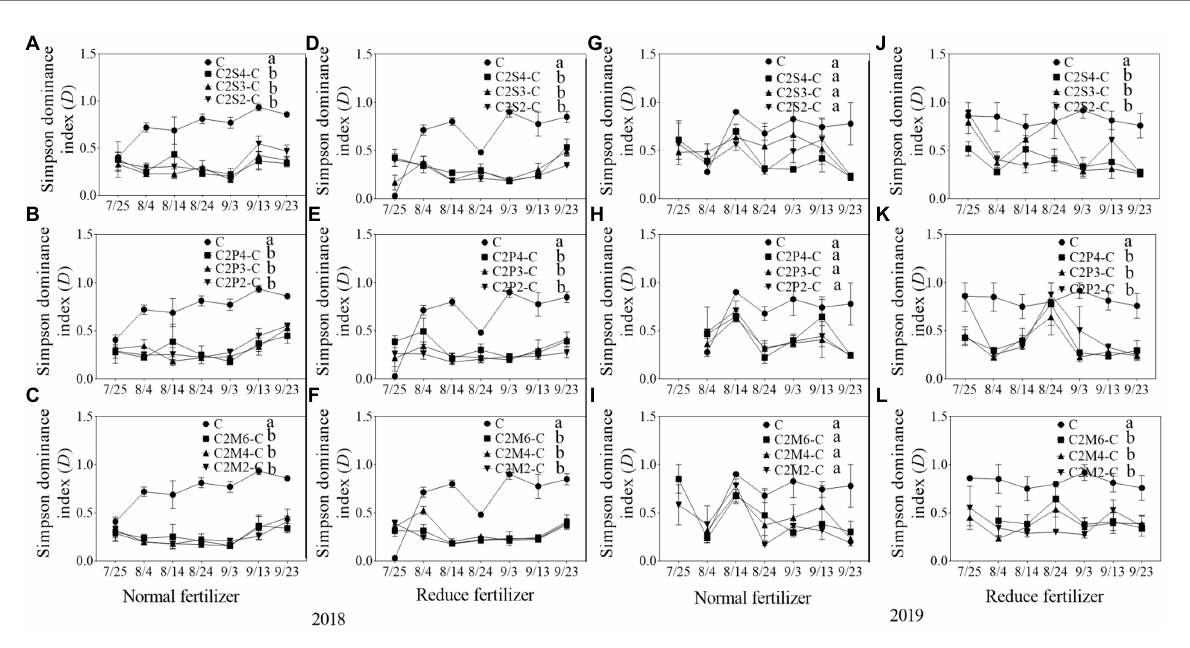
FIGURE 4 Simpson dominance index (D) of insect communities on corn plants intercropping with soybean, peanut, and millet under different planting patterns at normal and reduced fertilizer. A-C represent corn-soybean intercropping, corn-peanut intercropping and corn-millet intercropping under normal fertilizer in 2018, respectively. D-F represent corn- soybean intercropping, corn-peanut intercropping and corn-millet intercropping under fertilizer reduction in 2018, respectively. G-I represents corn-soybean intercropping, corn-peanut intercropping and corn-millet intercropping under normal fertilizer in 2019, respectively. J-L represent corn-soybean intercropping, corn- peanut intercropping and corn-millet intercropping under fertilizer reduction in 2019, respectively. C2S2-C, C2S3-C, C2S4-C: corn plants in the planting patterns of 2 corn rows intercropping with 2, 3, 4 rows of soybean; C2P2-C, C2P3-C, C2P4-C: corn plants in the planting patterns of 2 corn rows intercropping with 2, 3, 4 rows of peanut; C2M2-C, C2M4-C, C2M6-C: corn plants in the planting patterns of 2 corn rows intercropping with 2, 4, 6 rows of millet. Different lowercase represents a significantly different average of the 7 evaluations among different planting patterns at the same fertilizer level and the same intercropping type by the LSD test at p < 0.05,